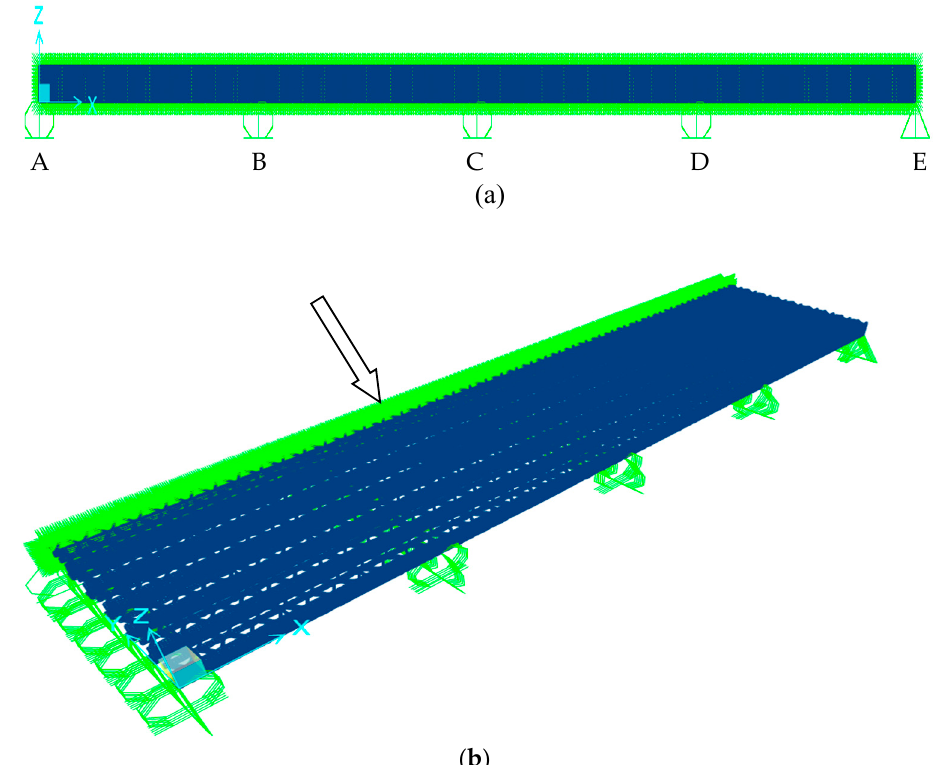
Figure 3. ( a ) Front view of the boundary conditions ( b ) isometric view of the boundary conditions [10].